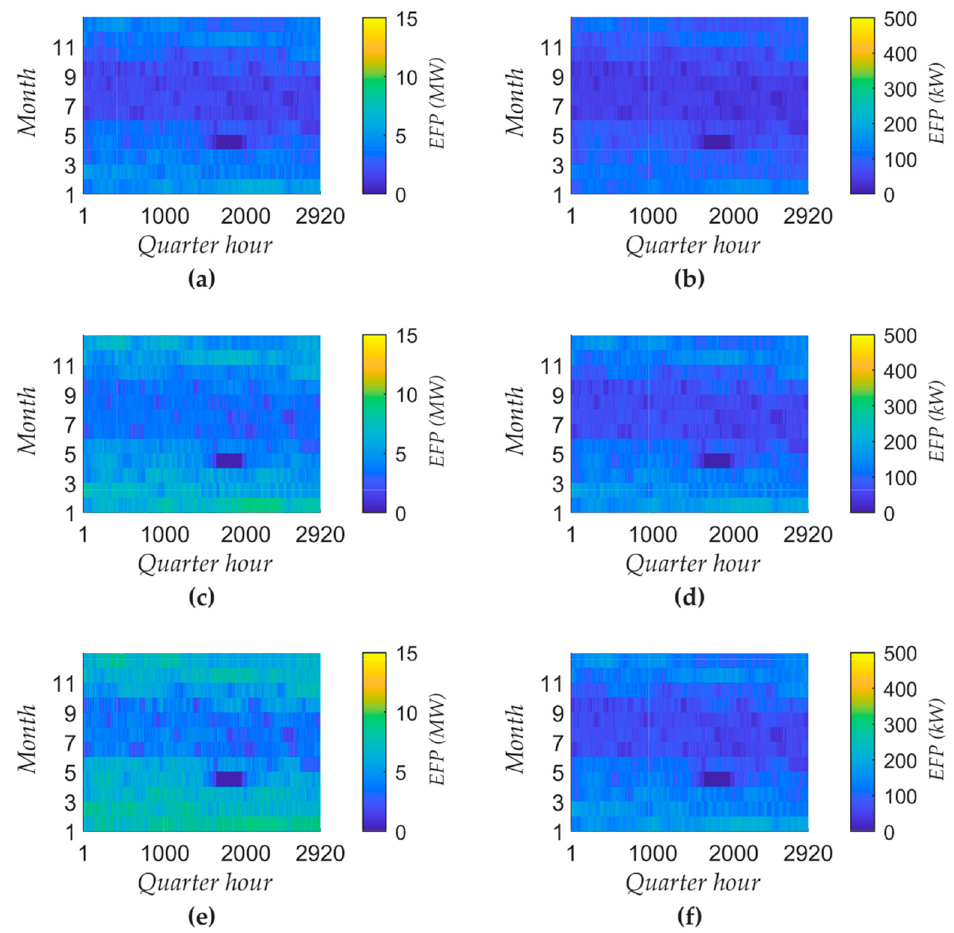
Figure 6. Technical energy-flexibility potential through operating with bivalent energy: ( a ) Primary balancing power of the evaporator; ( b ) Primary balancing power of the superheater; ( c ) Negative secondary balancing power of the evaporator; ( d ) Negative secondary balancing power of the superheater; ( e ) Negative minutes’ balancing power of the evaporator; ( f ) Negative minutes’ balancing power of the superheater.